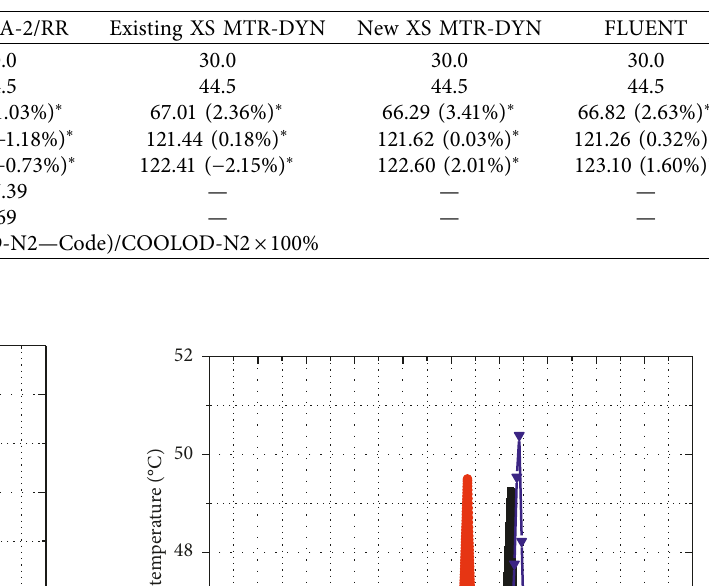
Table 2: Calculated thermal-hydraulic parameter on steady-state condition.